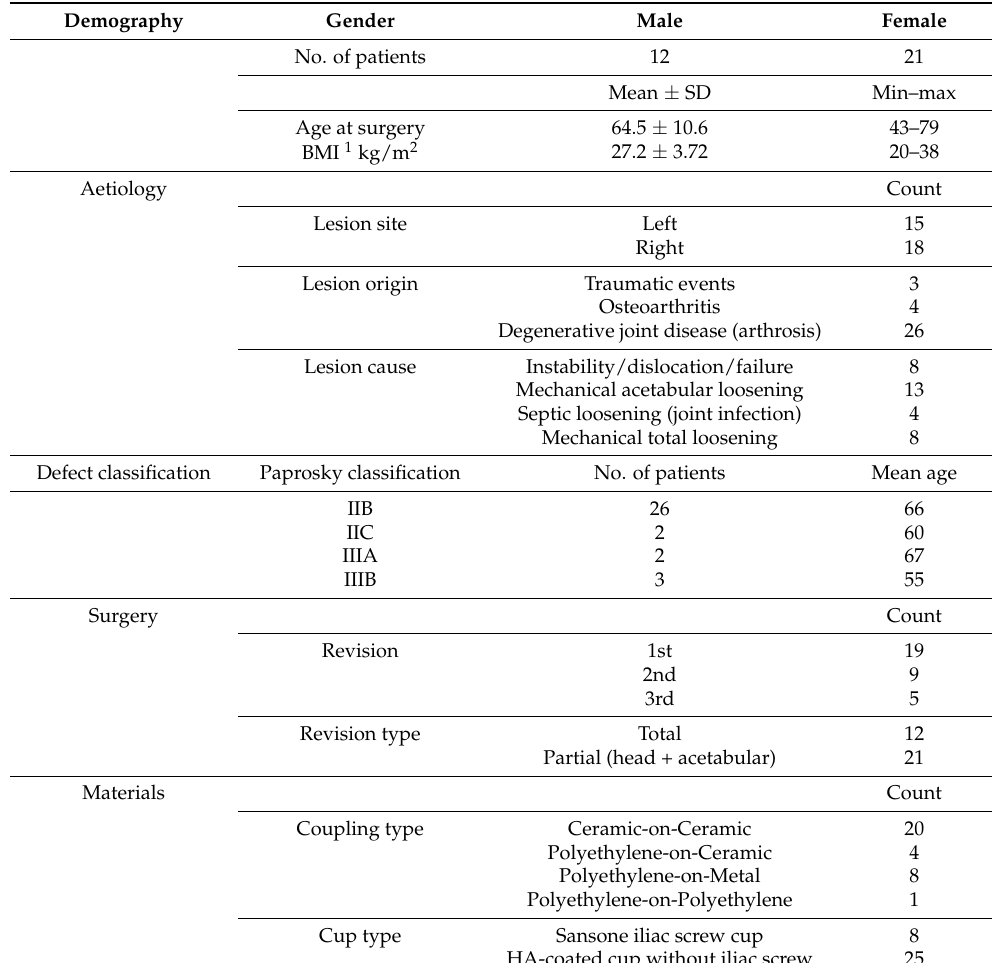
Table 1. Patient population: demography, aetiology, classification of defects, and information on